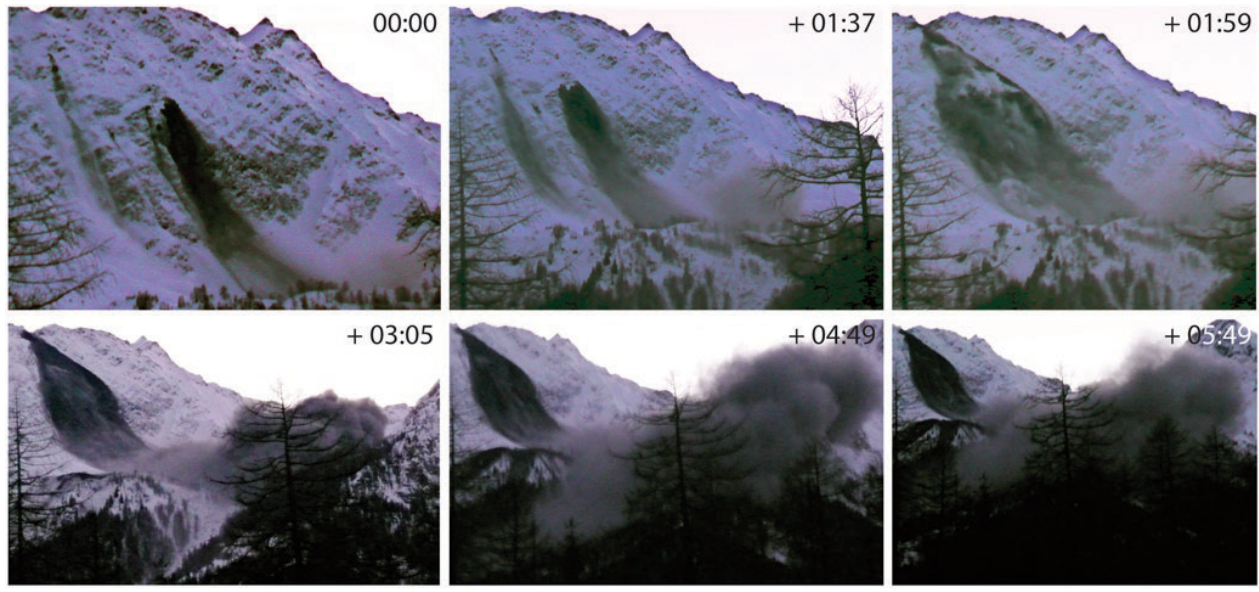
Fig. 4. Photographic sequence of the rock avalanche on the 24 December 2008 (E. Zerga). Time in mm:ss; 00:00 corresponds to ca. 17:21 (lo- cal